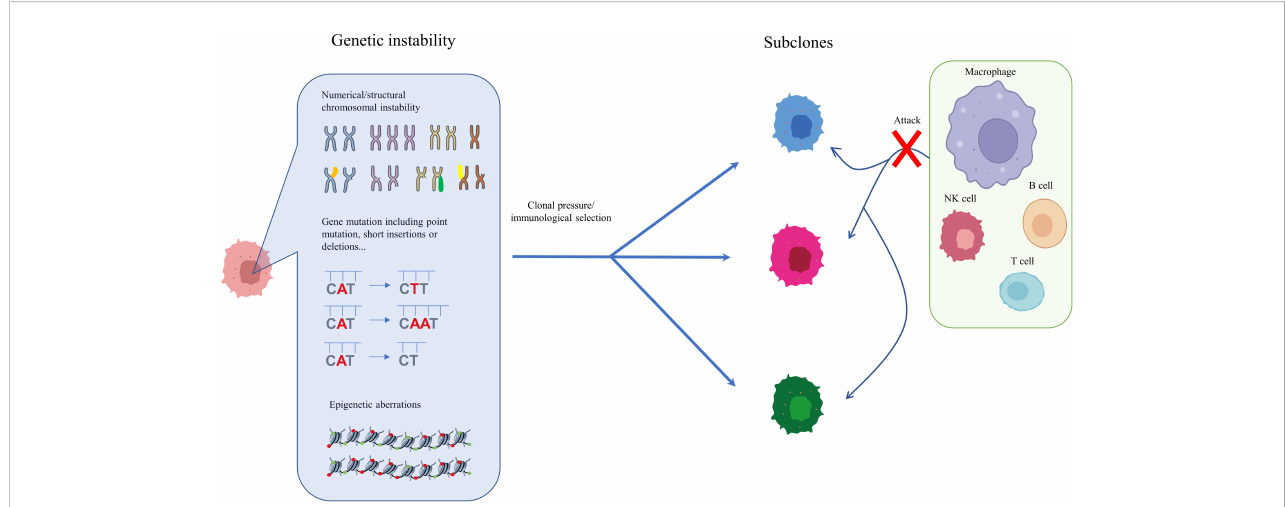
FIGURE 1 Genetic and epigenetic ITH in HCC. During the initial and subsequent development of HCC, only the fi ttest clones survive clonal pressure and immunological selection and accumulate in cancer cells. The diversity of surviving cells, which vary in genetic instability, immune escape, and degree of treatment resistance, is considered one reason for the genetic heterogeneity of HCC, which confers on HCC an evolutionary growth advantage. Enhanced genetic ITH normally leads to aggressiveness, immune escape, and resistance to treatment, which is associated poor outcomes and worse prognosis in HCC